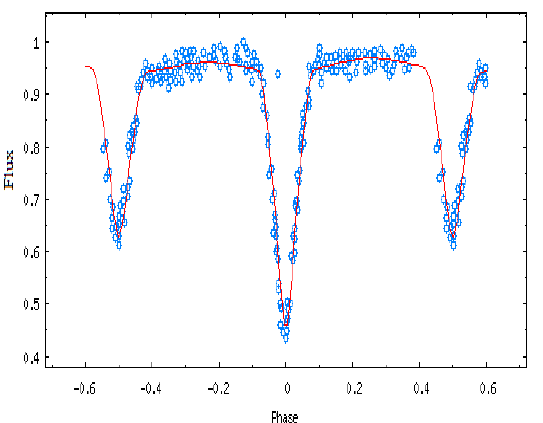
Fig.6: The best match between the synthetic light curve and the experimental light curve of binary BH Vir.